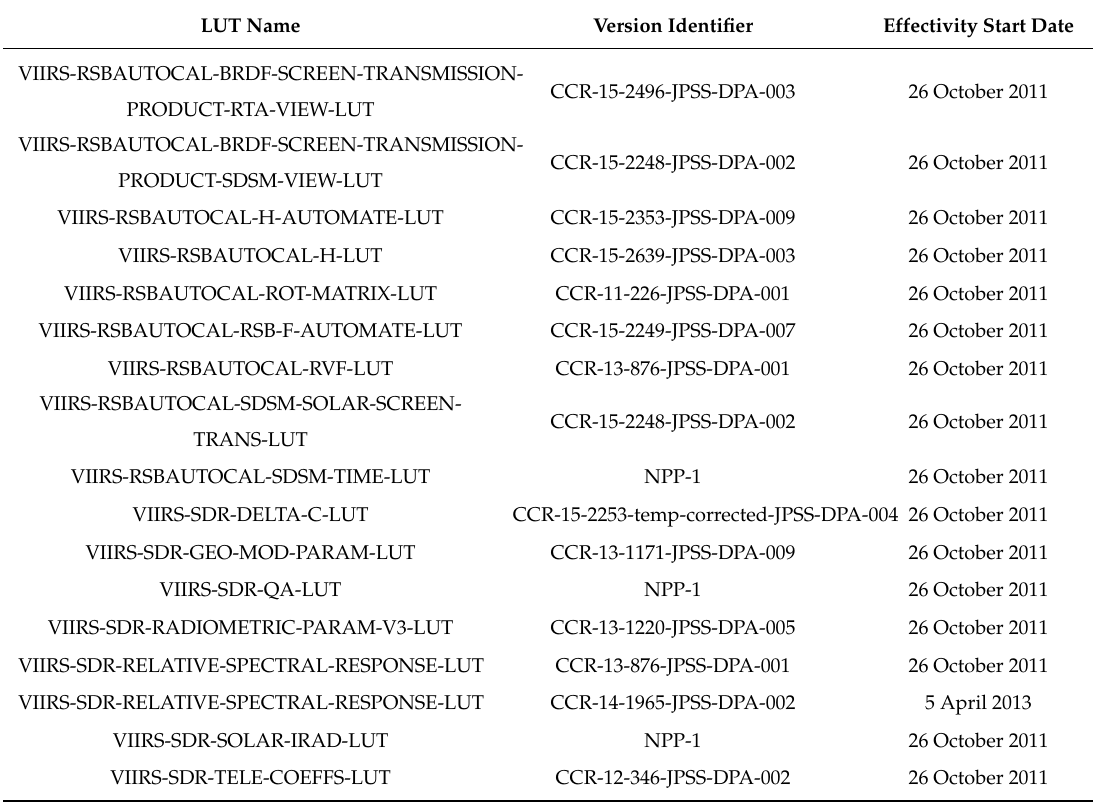
Table 1. Lookup tables applied in the VIIRS RSB calibration